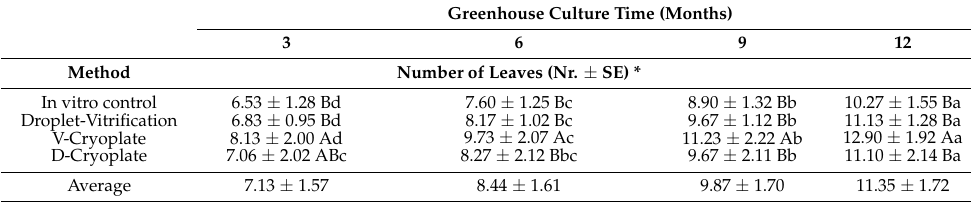
Table 3. Comparison of number of leaves between in vitro controls and cryo-derived plants of Vanilla planifolia during greenhouse